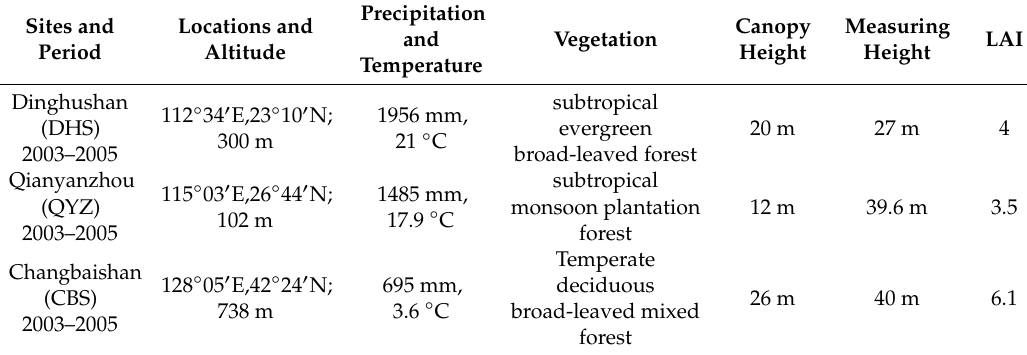
Table 1. The background of three ChinaFLUX forest sites [33]. Precipitation and temperature are